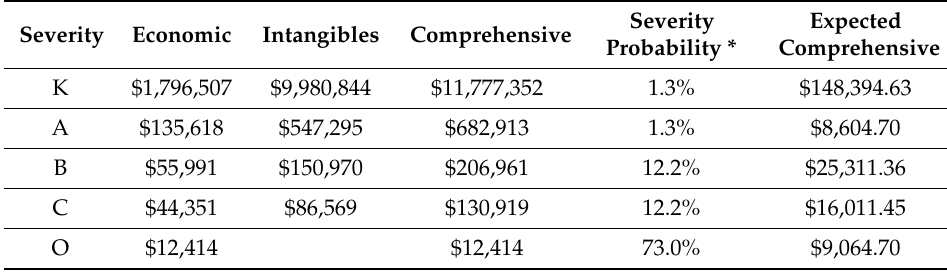
Table 3. 2019 crash unit costs (modified from Harmon et al.